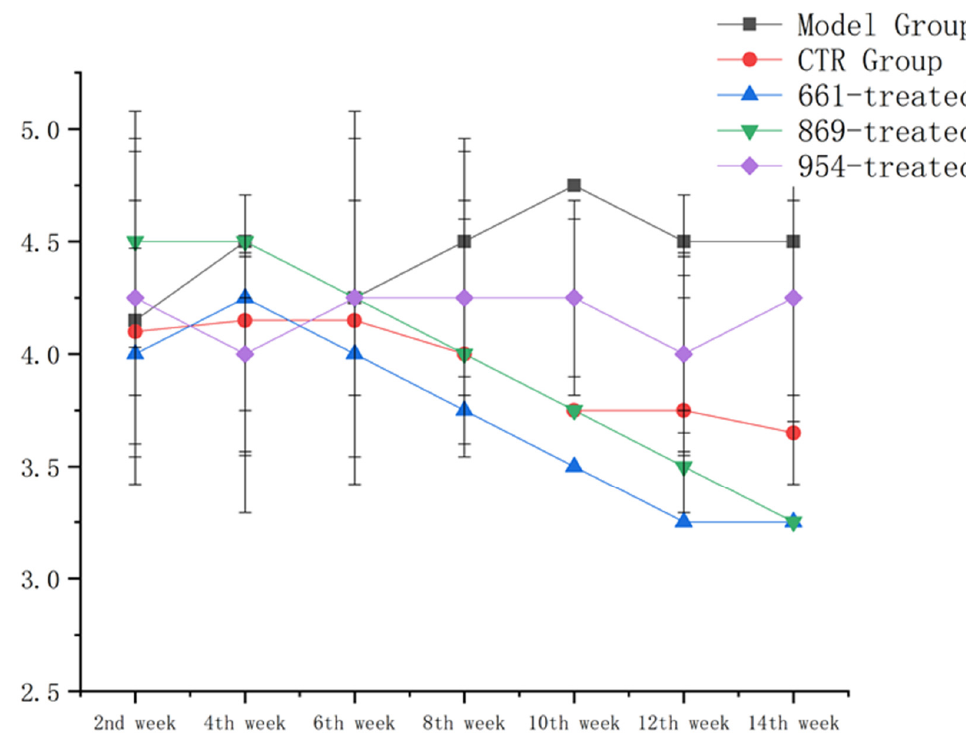
Figure 4. Proteinuria value of each group in different weeks.